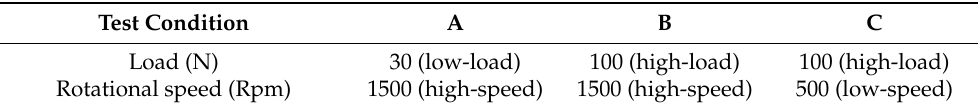
Table 4. Friction test